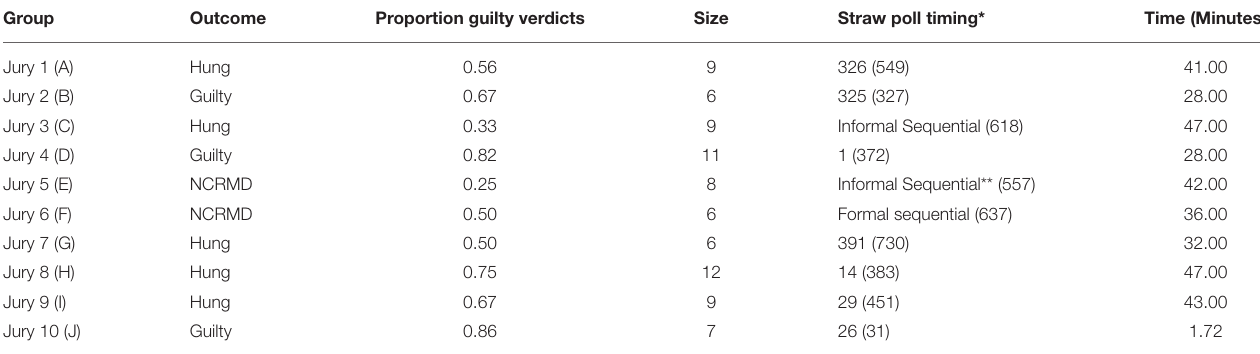
TABLE 5 | Demographics broken down by discussion group. Age Gender Racial composition Know person with Mean (SD) Man Woman Trans White Another